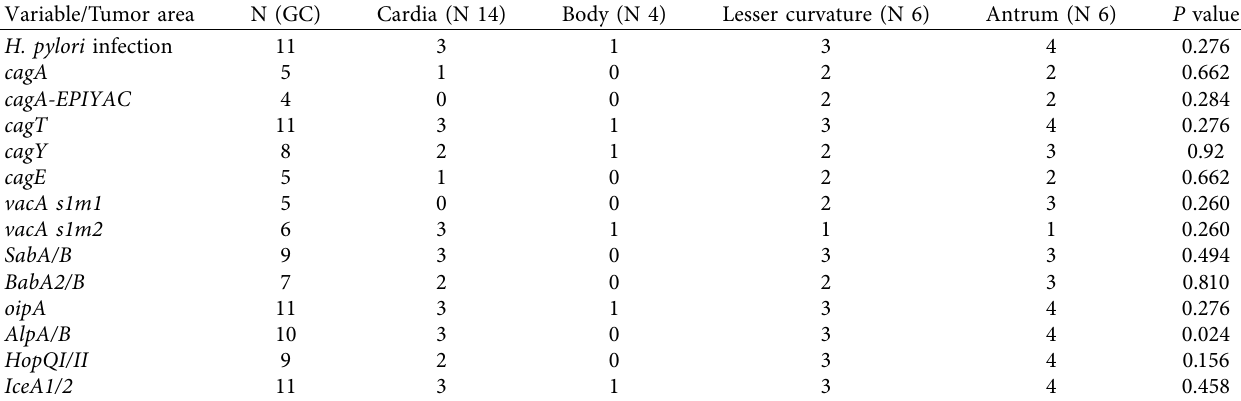
Table 5: Frequency of H. pylori virulence genes’ cDNA in gastric antral biopsy samples of gastric carcinoma patients with stomach tumors in different areas.